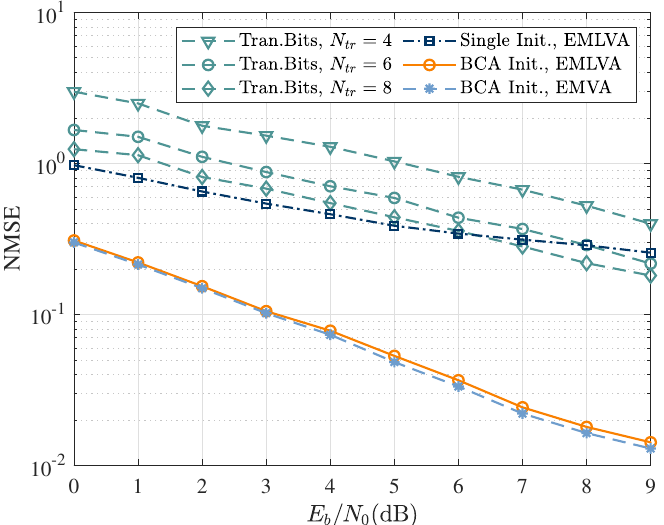
Figure 7. NMSE as a function of E b / N 0 for training-based channel estimation. EMVA with single fixed initializer; EMLVA and EMVA with BCA